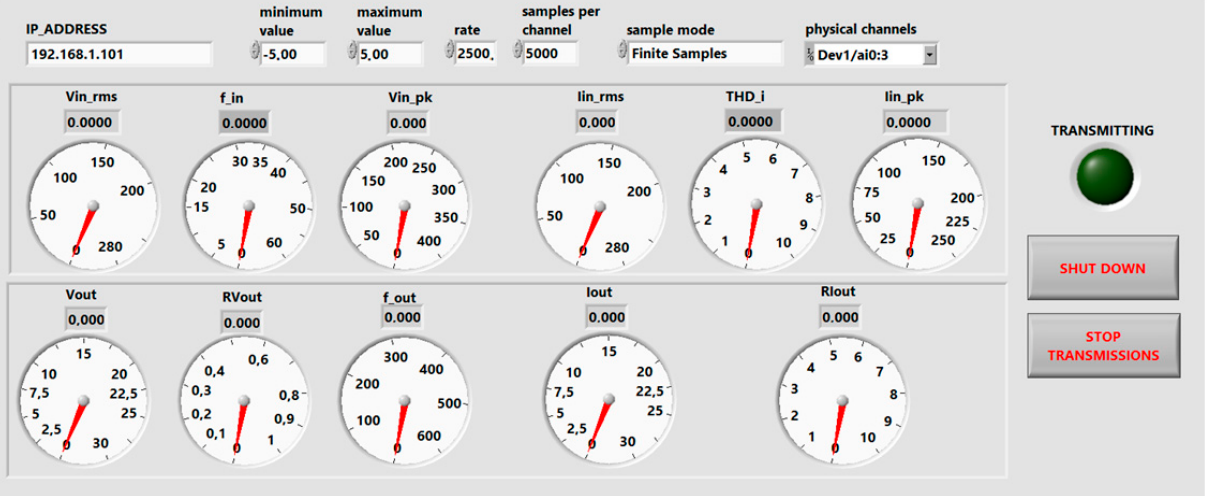
Figure 5. Front panel of the measurement system LabVIEW software.